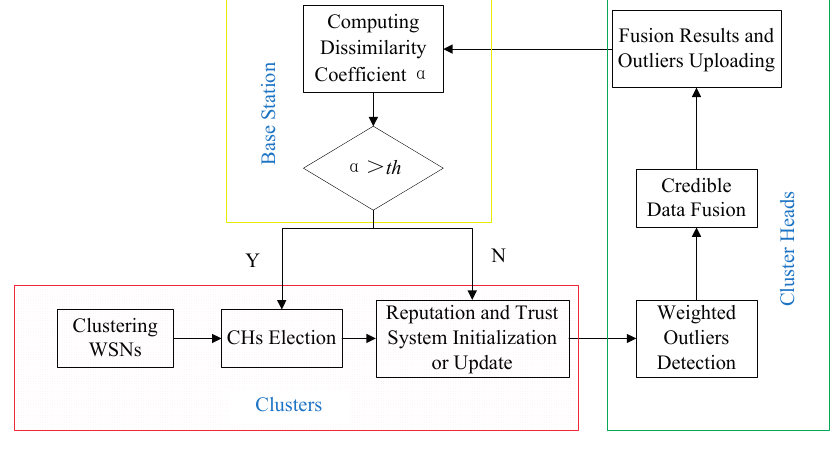
Figure 3. Overview of the